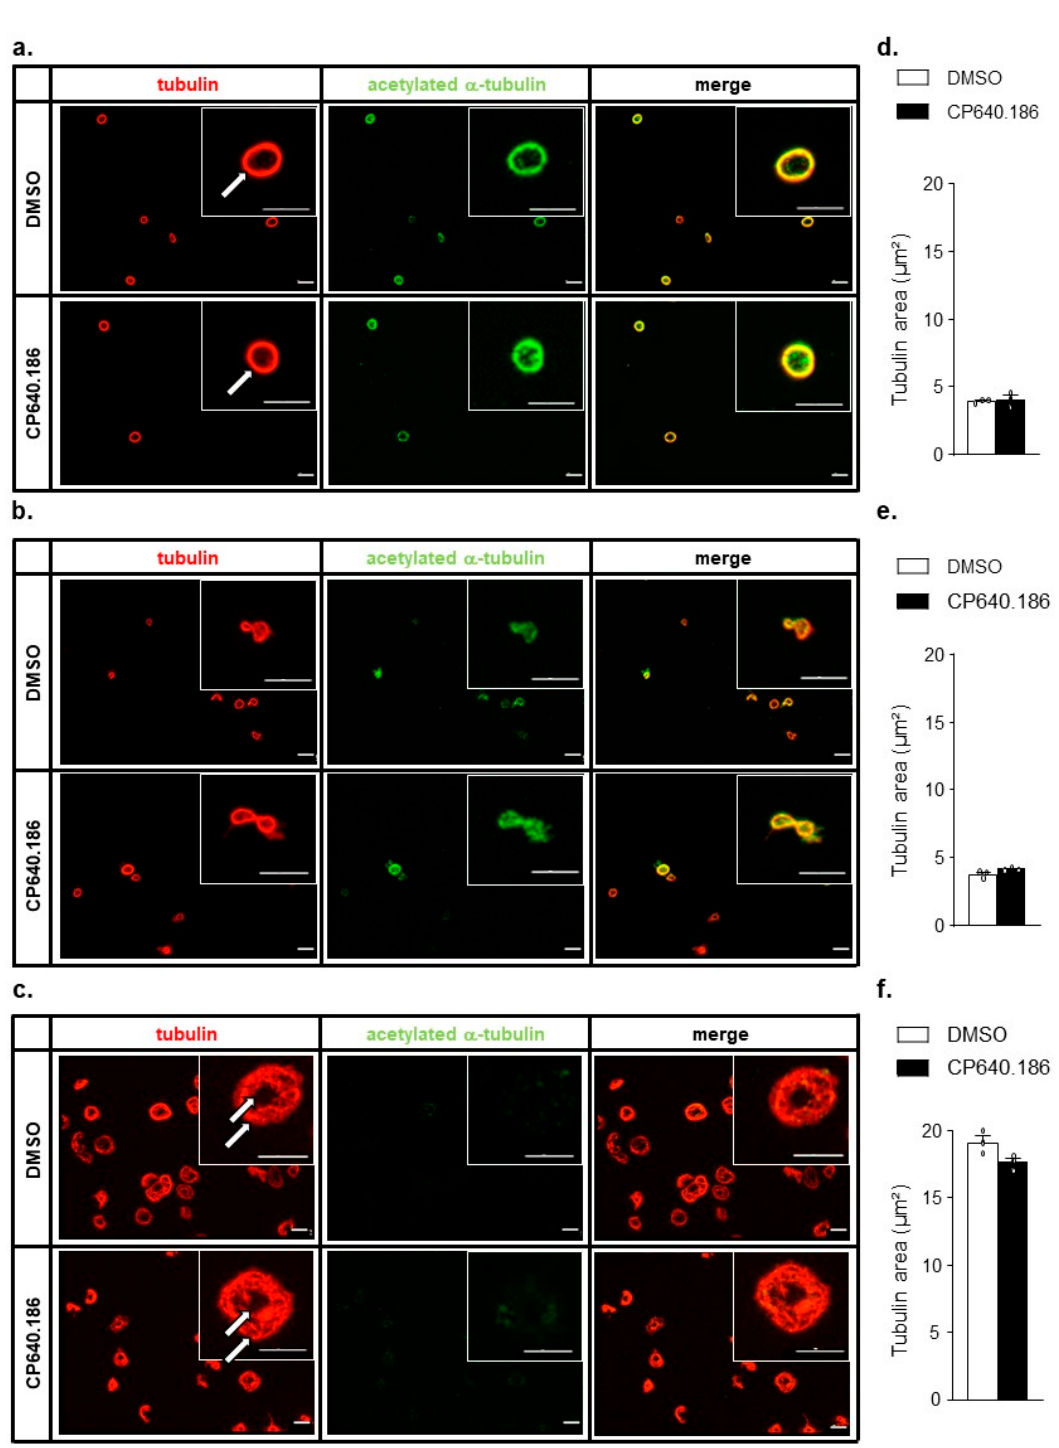
Figure 3. CP640.186-induced ACC inhibition does not affect microtubule dynamics. ( a – f ) Washed human platelets were pre − incubated for 2 h with dimethyl sulfoxide (DMSO) or CP640.186 (60µM) before being added to fibrinogen − coated coverslips for 10 min. ( a ) Unstimulated platelets were fixed directly using 1% PFA, before being added to coverslips. ( b ) Platelets were added to coverslips before being fixed with 1% PFA. ( c ) Platelets were stimulated with 100mU/mL thrombin and then added to coverslips before being fixed with 1% PFA. ( a – c ) Platelets were stained using tubulin (red) or acetyl α -tubulin (green) antibodies. Representative pictures are shown. Microtubule rings are indicated by white arrows. Scale bar: 5 µ m. ( d – f ) Quantification of tubulin area. Data were expressed as means ± SEM ( n = 3). Data were compared using unpaired t − test.